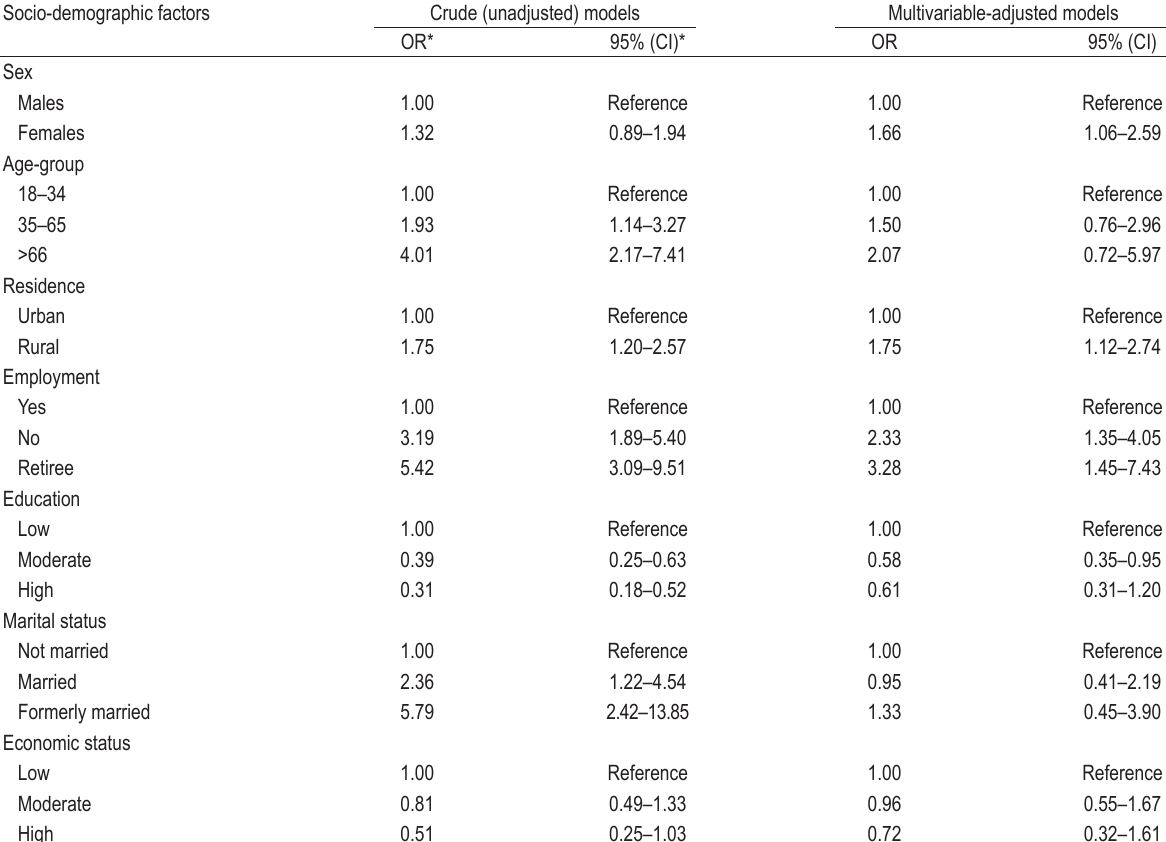
TABLE 2. Socio‑demographic factors associated with Physical inactivity Socio‑demographic factors Crude (unadjusted)